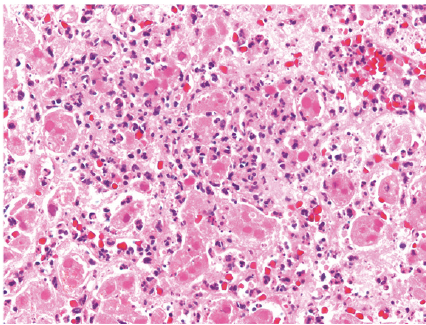
Figure 7: Liver biopsy from patient 3 showing intranuclear viral inclusions within the necrotic areas.